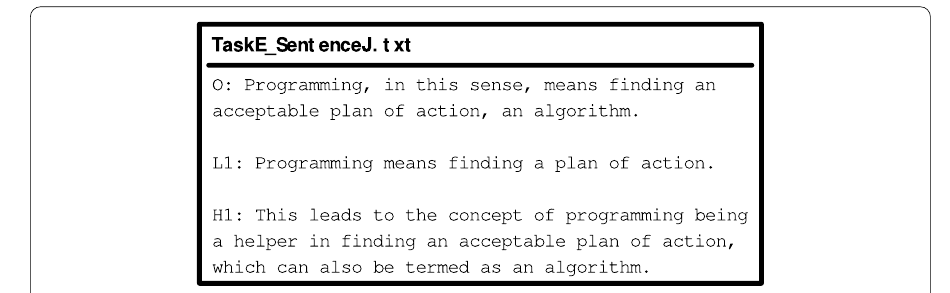
Fig. 5 A Sample File in the Subcorpus of Paraphrased Sentences (Alvi et al.